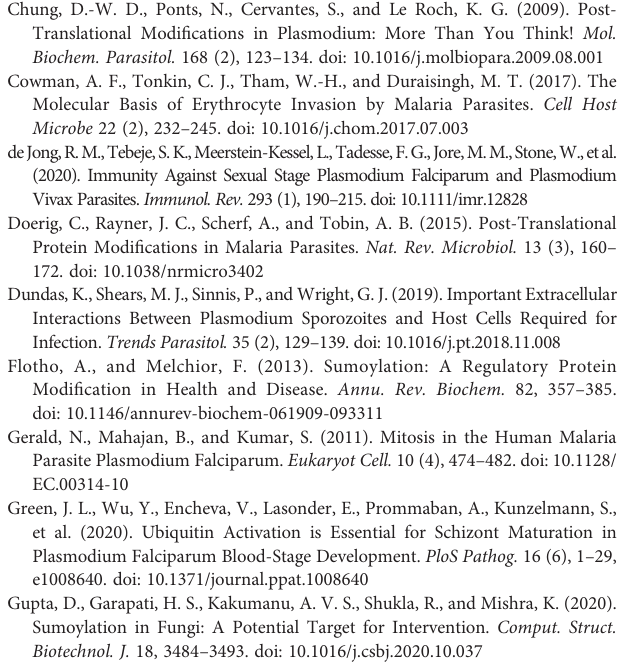
Figure 1B was adapted from “ CellTypeTemplate ” , by